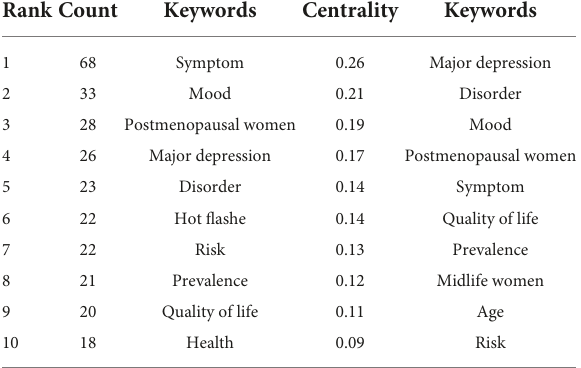
TABLE 9 Top 10 keywords in terms of frequency and centrality on